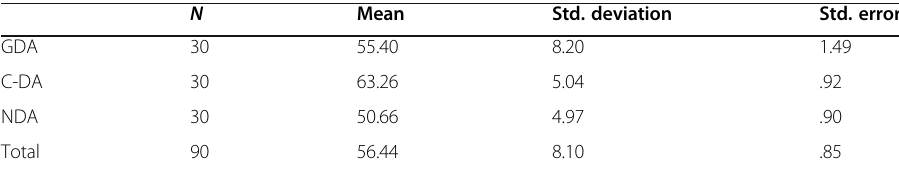
Table 7 Descriptive statistics for comparing the speaking fluency post-test scores of the GDA, C- DA, and N-DA learners N Mean Std. deviation